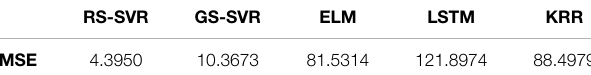
TABLE 5 | RMSE data obtained for different prediction models.